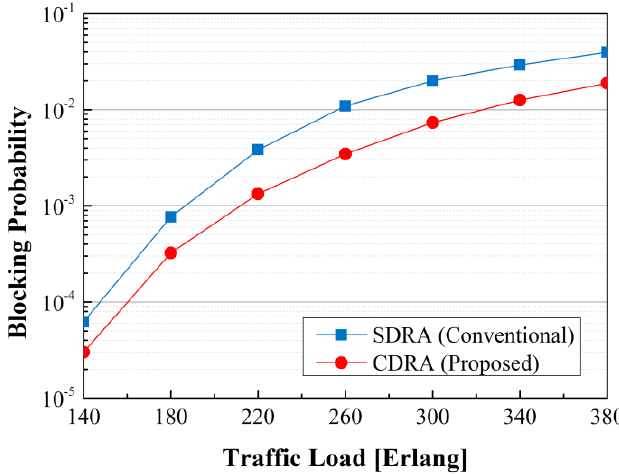
Figure 8. Performance comparison in terms of blocking probability.